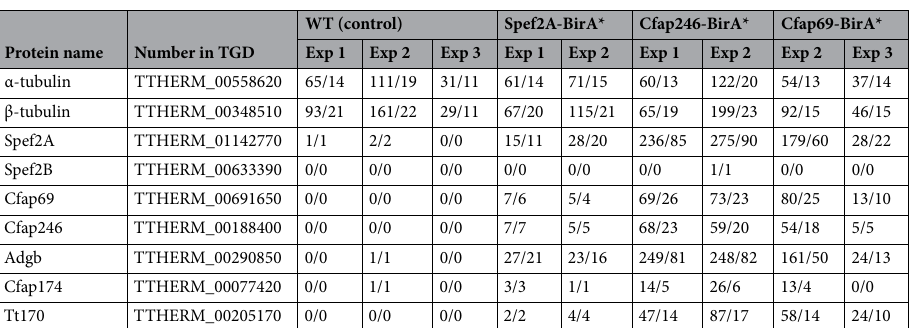
Table 1. Mass spectrometry-based identification of ciliary proteins biotinylated in cells expressing an indicated BirA*-tagged protein. Table shows the numbers X/Y; (X) number of all identified peptides (in a Mascot program, all significant matches), (Y) number of all unique peptide sequences (in a Mascot program, significant sequences). Complete data are presented in S2-S4 Tables. TTHERM- numbers in Tetrahymena Genome Database